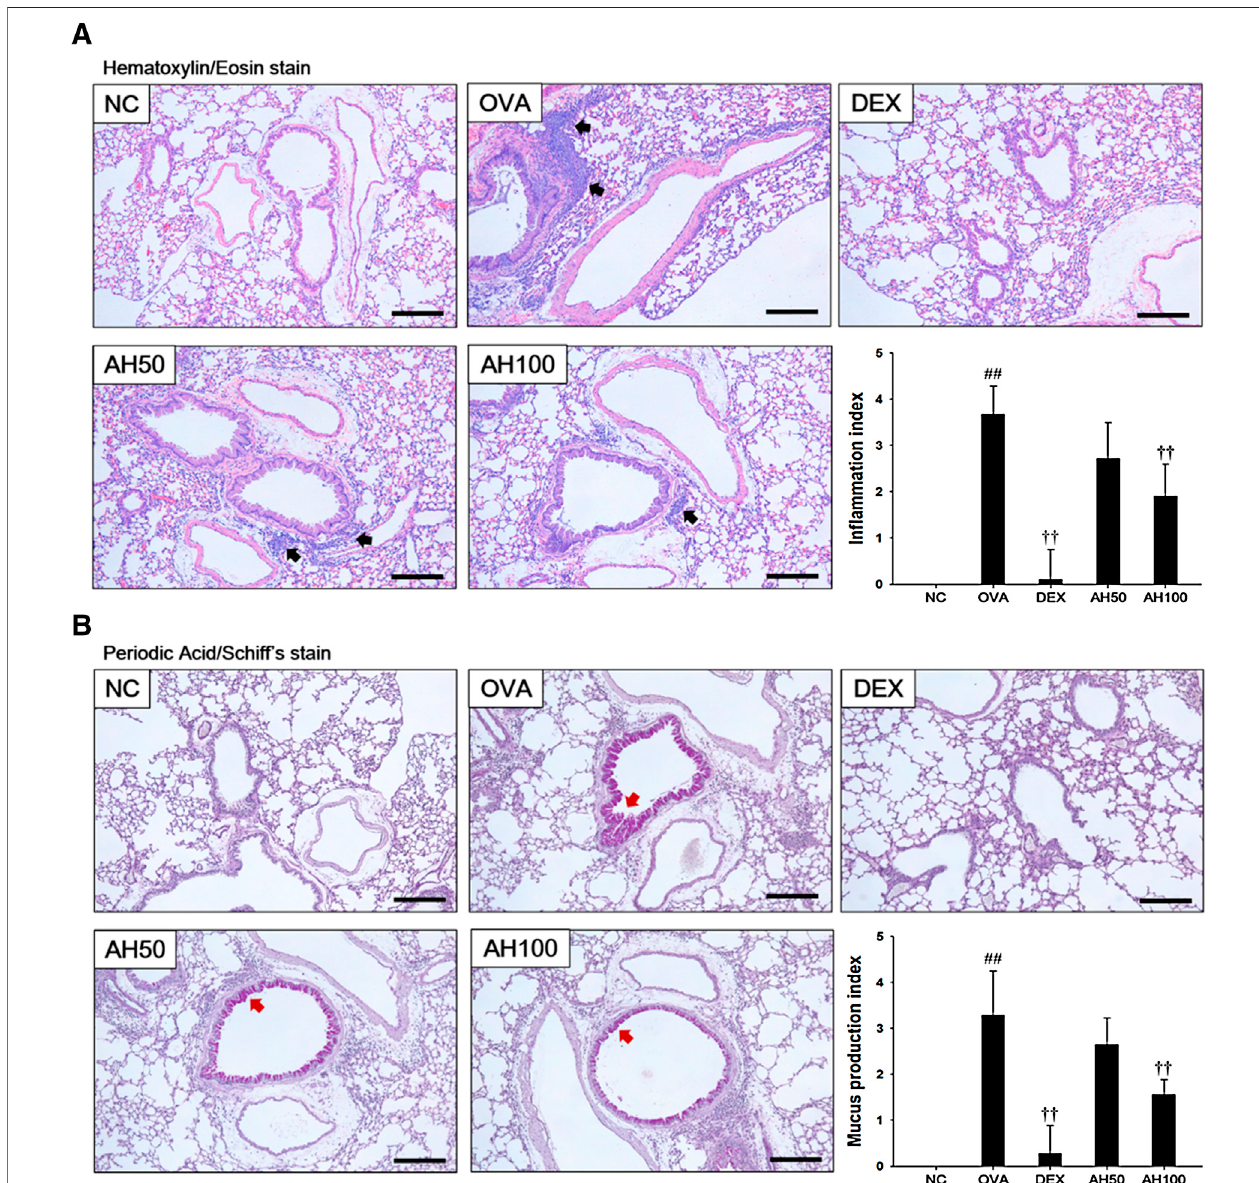
FIGURE 4 | AH treatment attenuated airway in fl ammation and mucus production in lung of mice 48 h after fi nal OVA challenge. Histopathological analysis on airway in fl ammation and mucus production was performed in the lung tissues by (A) H&E and (B) PAS staining. Black-colored arrow indicated the lesion of in fl ammatory cells in fi ltration. Red-colored arrow indicated mucus production. Scale bars, 50 μ m. NC: normal control mice; OVA: OVA- challenged asthma mice; DEX: dexamethasone (3 mg/kg) + OVA-challenged asthma mice; AH: AH (50 or 100 mg/kg) + OVA-challenged asthma mice. The values expressed as the means ± SD (n (cid:2) 7/group). ## p < 0.01, signi fi cantly different from NC group; †† p < 0.01, signi fi cantly different from OVA- challenged group.